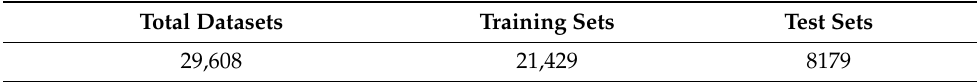
Table 1. Dataset composition of deep prediction model.